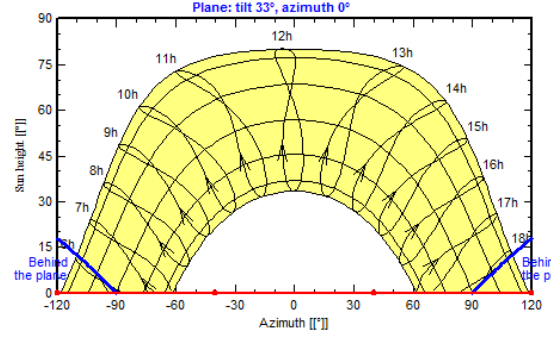
Figure 5. Horizon line drawing – Legal